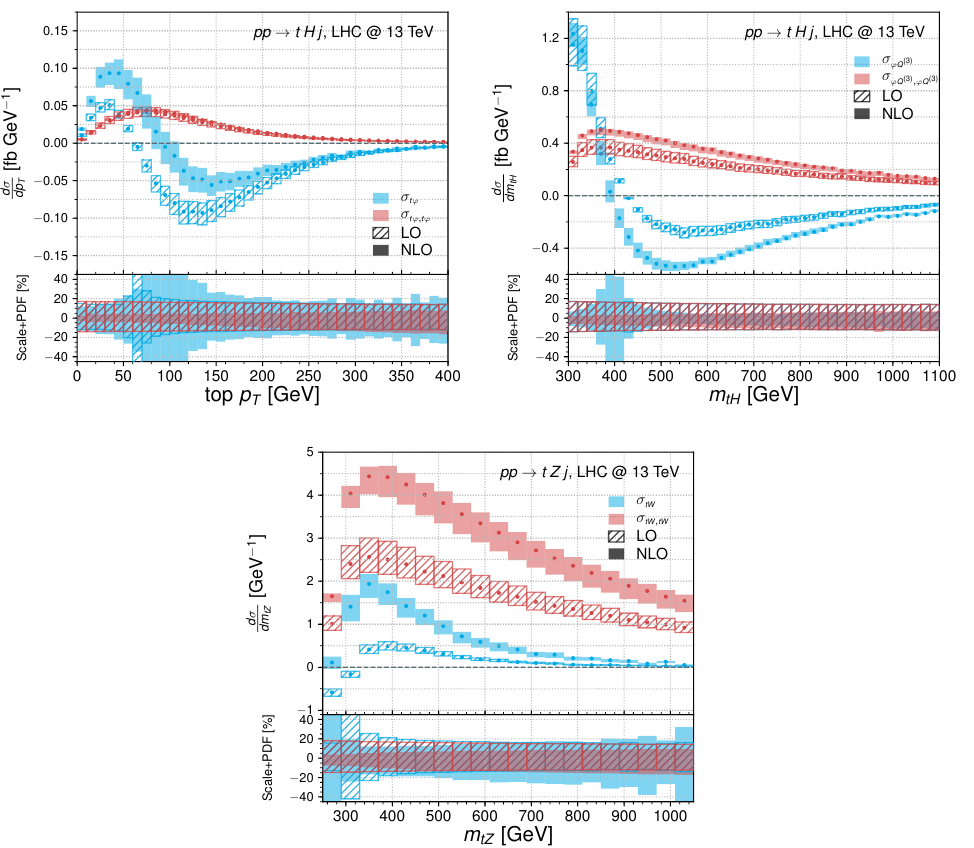
(3) and and similarly for the ’Q O t’ O 2 of the corresponding Wilson coe(cid:14)cient. Hatched (cid:0)